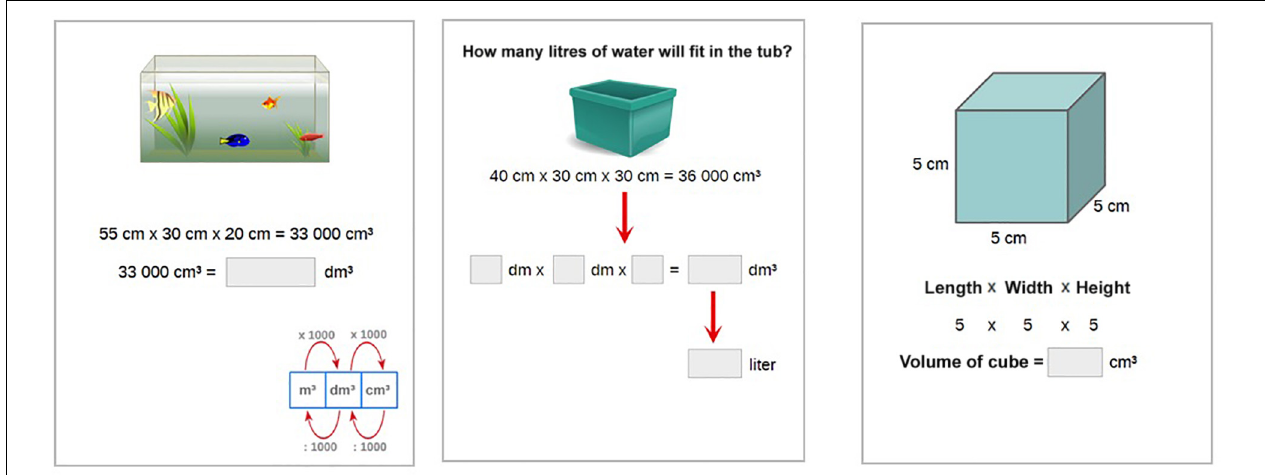
FIGURE 3 | Examples of items for the three subskills in the pre- and post-test.